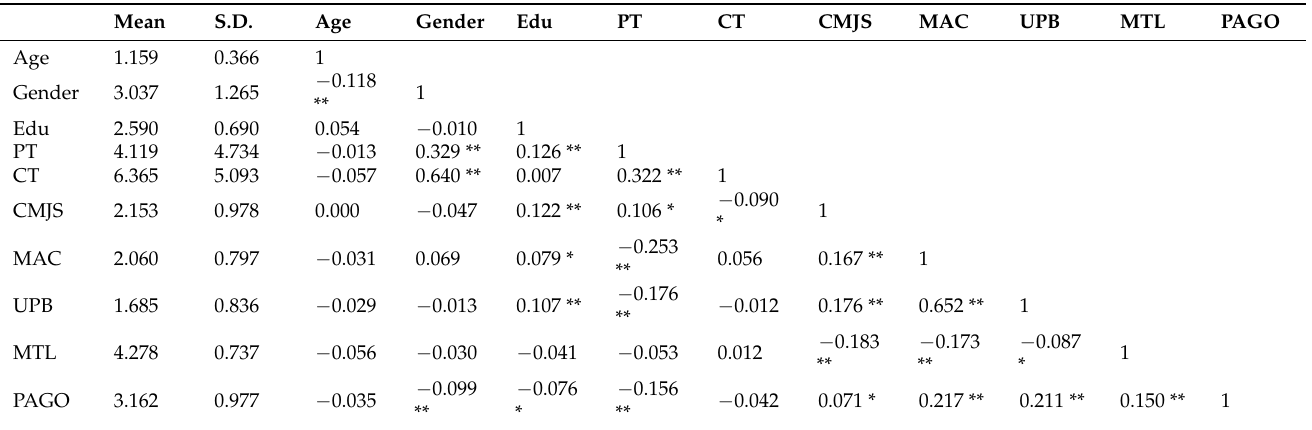
Table 2. Descriptive Statistics and Pearson Correlation